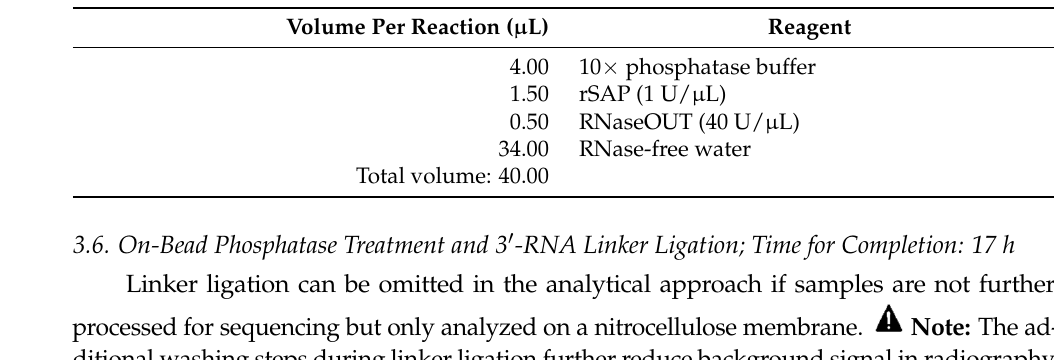
Prepare RT mix (Table 8): Table 8. Reverse Transcription Mix.